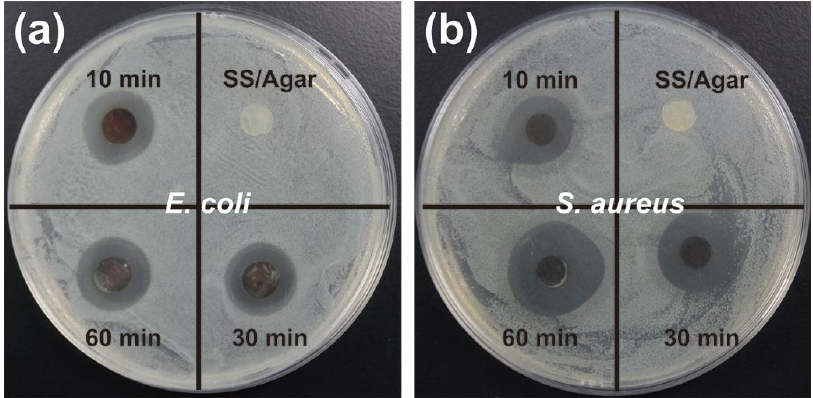
Figure 9. The inhibition zone assay of the SS/agar and AgNPs/SS/agar films. ( a ) E. coli and ( b ) S. aureus . Table 1. The diameters of the formed inhibition rings by the AgNPs/SS/agar films with different UV irradiation times.